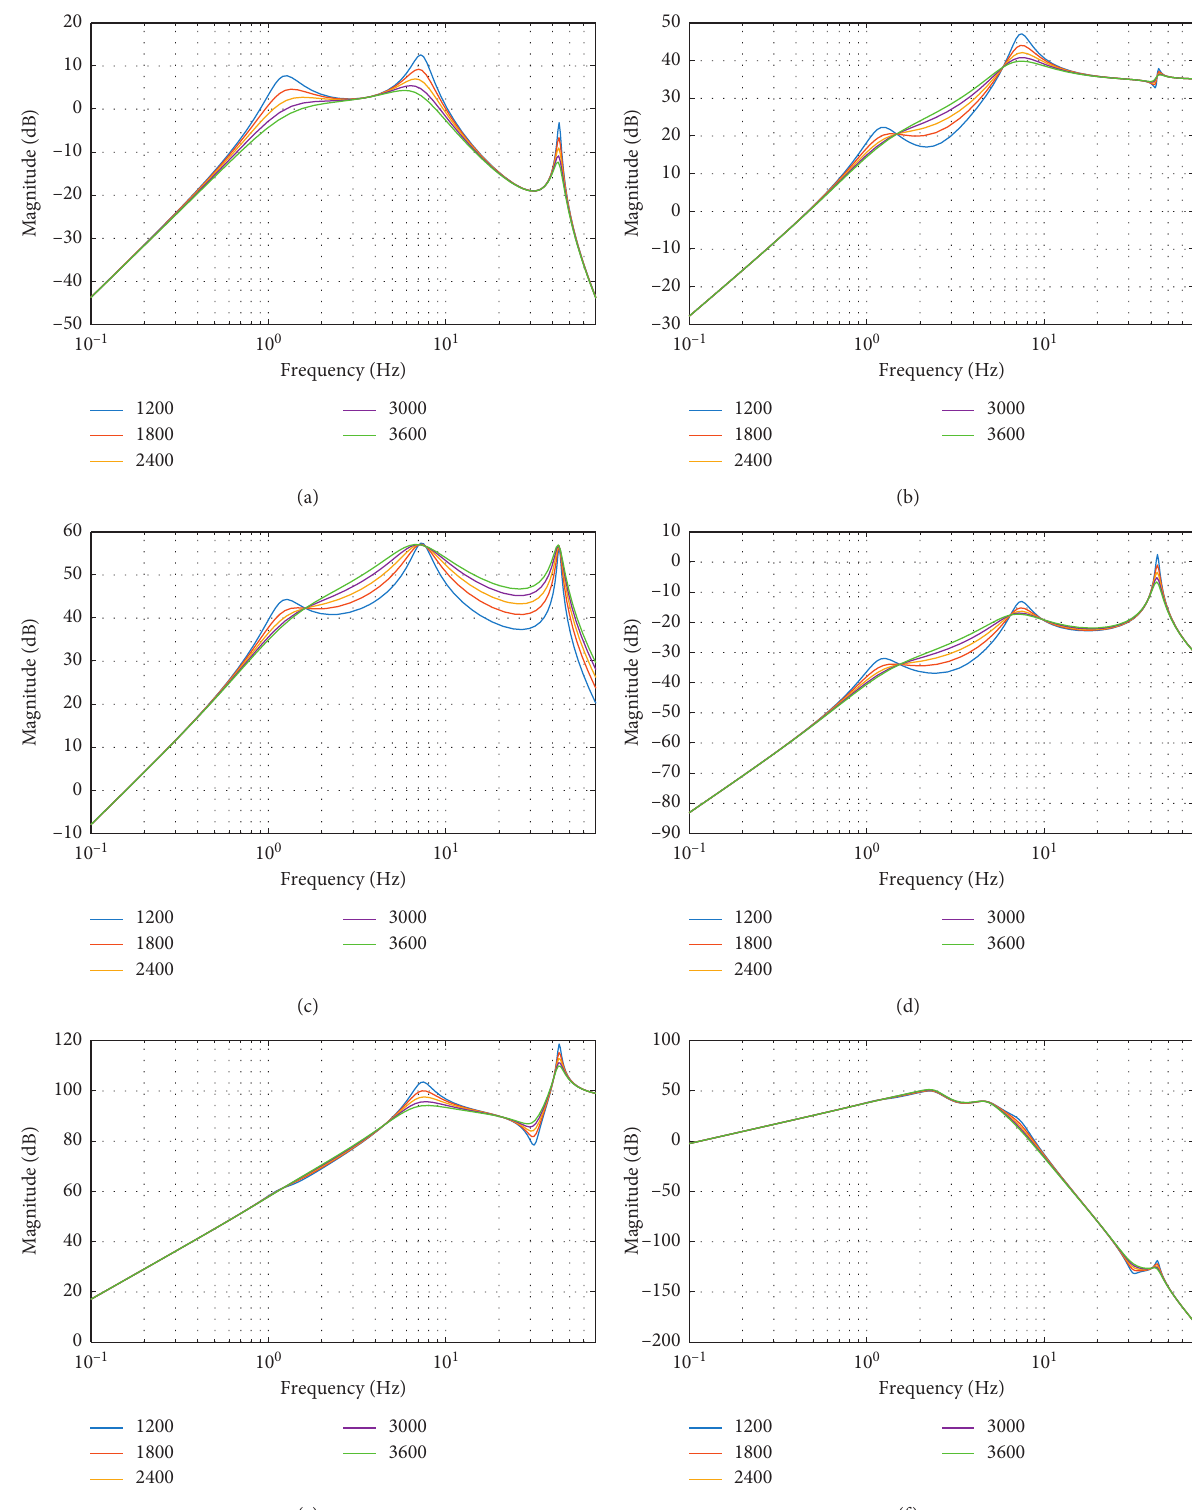
Figure 16: HDD-AS system transmissibility ratios with different damping coefficients. (a) Suspension deflection. (b) Tire dynamic load. (c) Sprung mass vertical acceleration. (d) Eccentricity. (e) Longitudinal driving force. (f) Motor